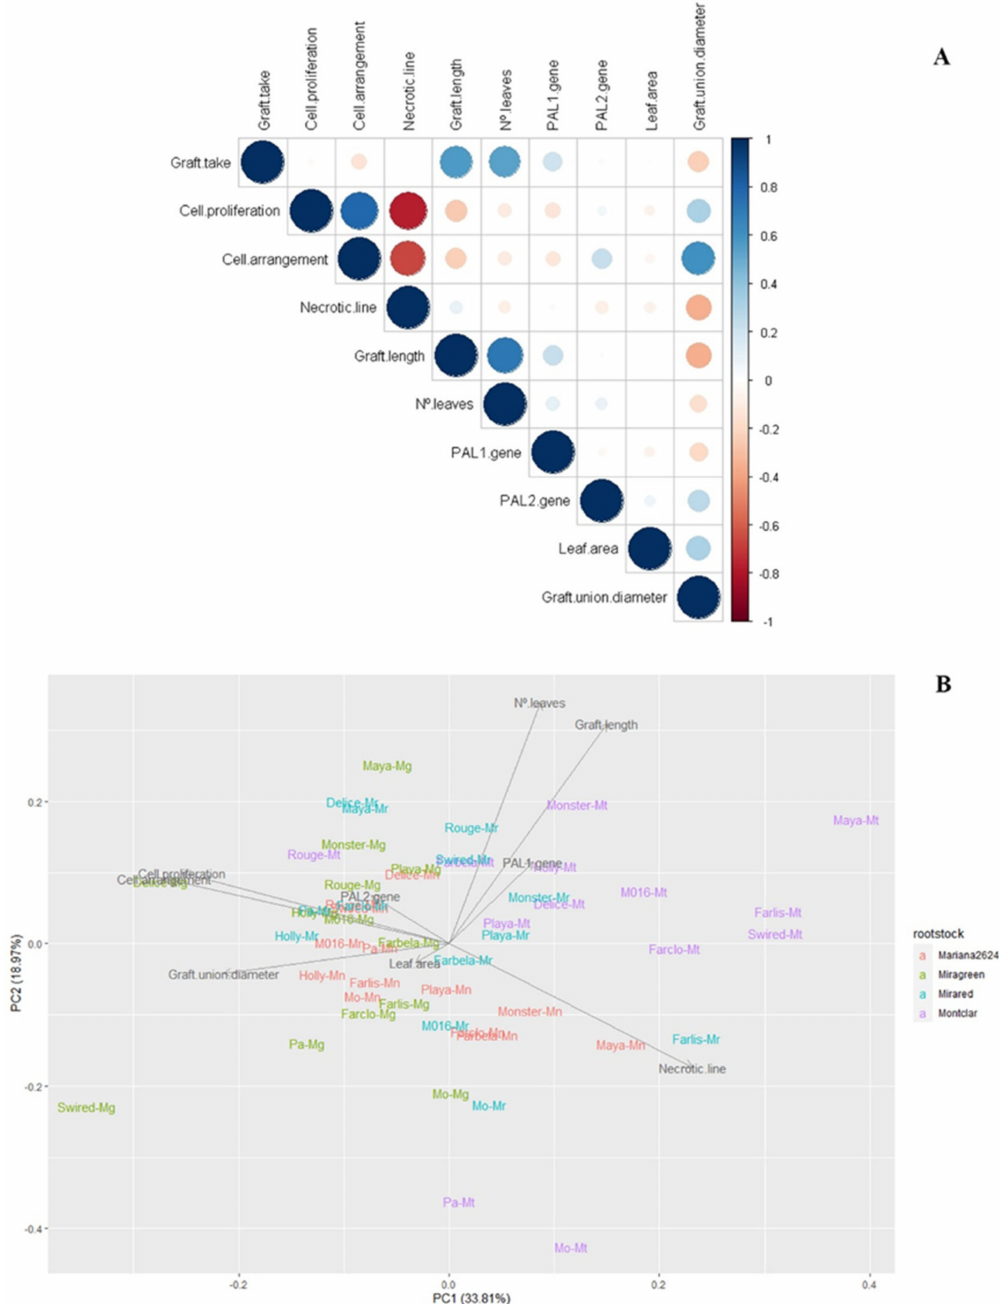
Figure 8. Pearson’s correlation coefficient ( A ) and principal component analysis (PCA) ( B ) for the traits studied in all combinations at 42 days, three months, and one year after grafting. In PCA, the colors are determinated by the rootstocks (green ‘Mg’ = ‘Miragreen’, purple ‘Mt’ = ‘Montclar’, blue ‘Mr’ = ‘Mirared’, red ‘Mn’ =